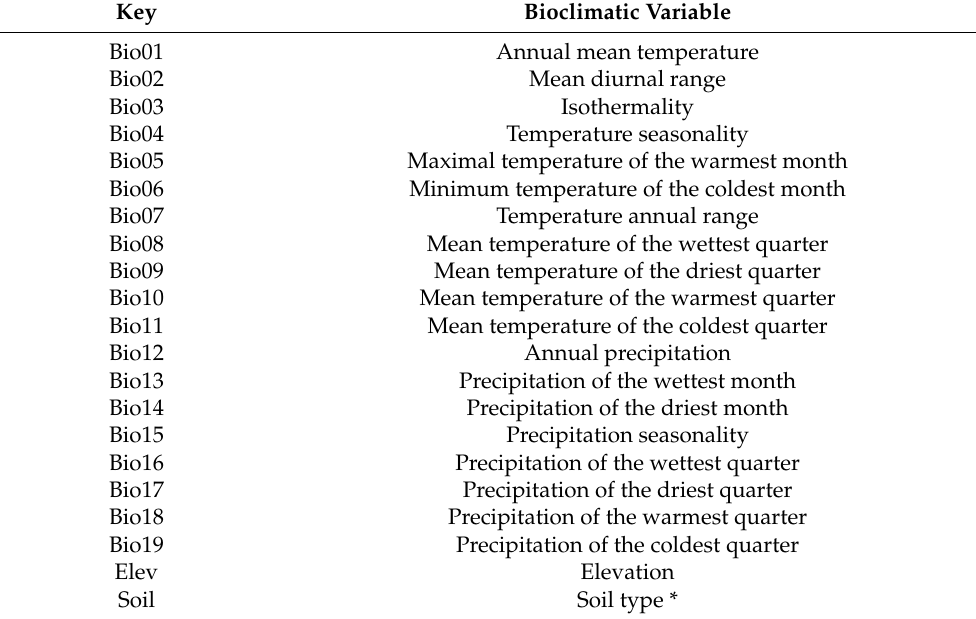
Table 2. Environmental variables used for the species distribution modeling of Hass avocado and threatened pollinator species in